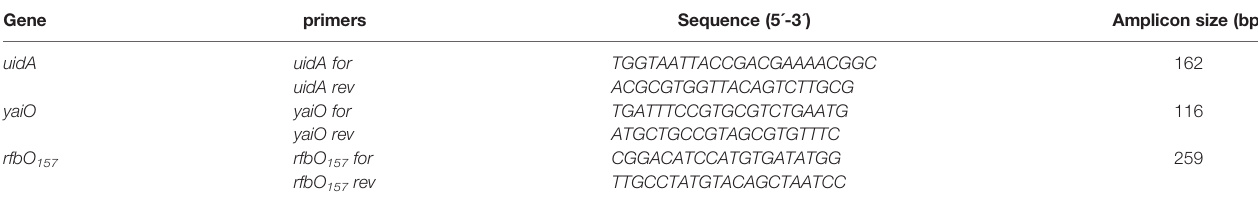
TABLE 1 | Primers